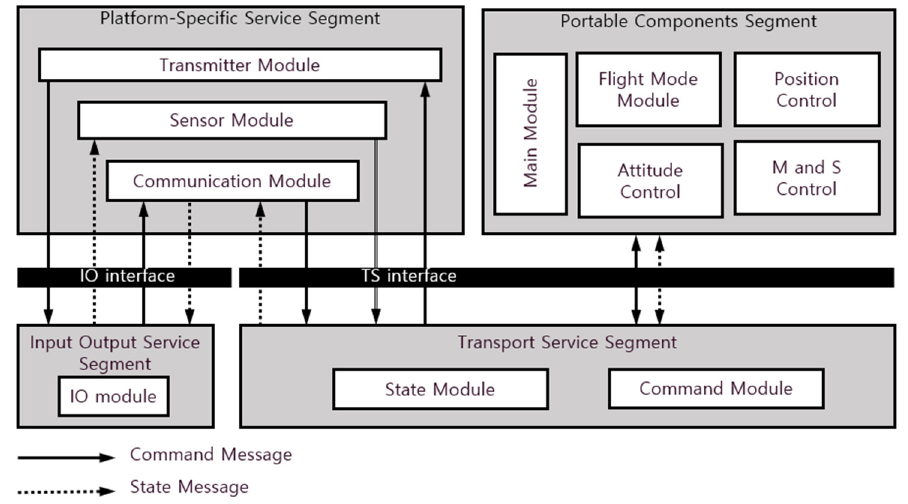
Figure 6. Data flow of the mpFCS .